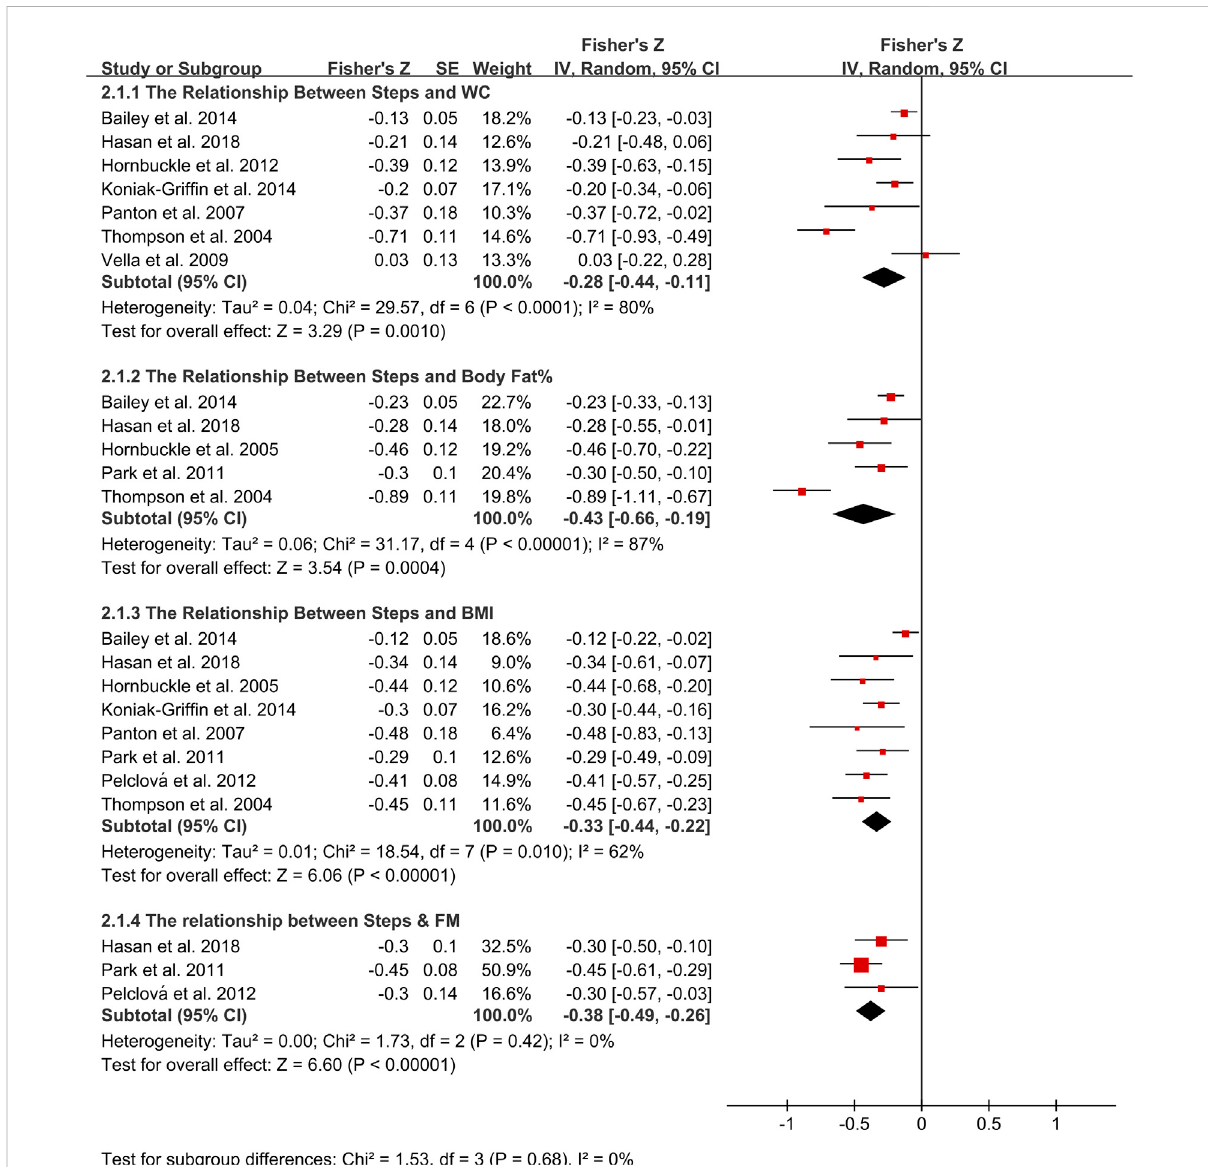
Forest plot of correlation between steps and adiposity outcomes. Overall pooled correlation for random effects model represented by black diamond. Note: BMI, body mass index; FM, fat mass; WC, waist circumference.